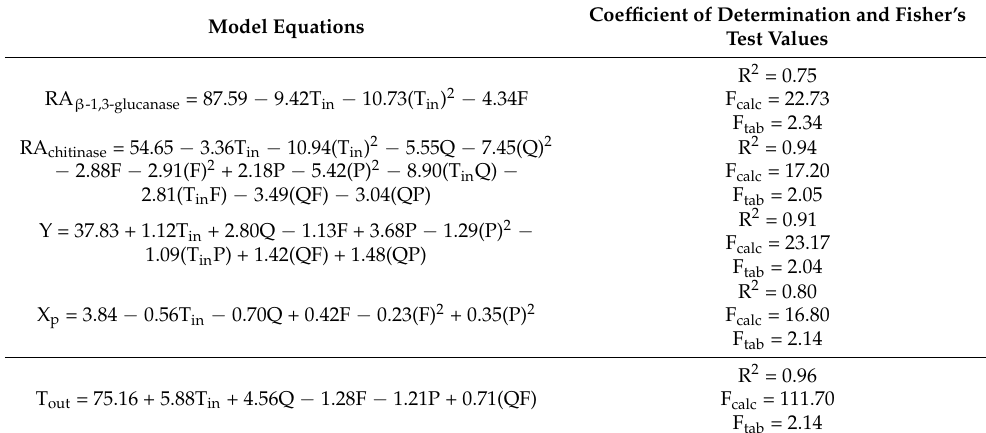
Table 5. Adjusted models of the Central Composite Rotatable Design (CCRD) dependent variables. Model